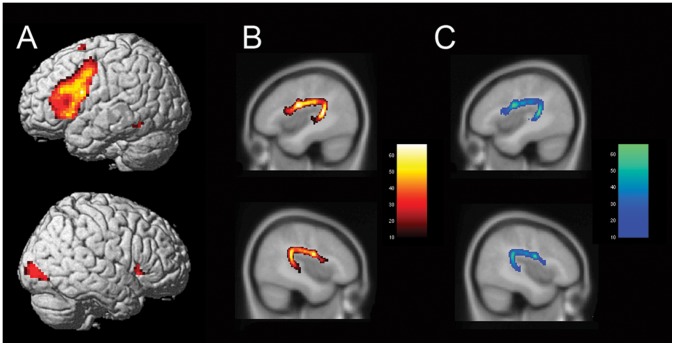
Brain activity and the arcuate fasciculus.Averaged brain activity during word generation task (A) and reconstruction of the arcuate fasciculus on the B) 1% threshold and C) 2% threshold, respectively. Colour bars represent the number of subjects showing arcuate fasciculus fibers in that voxel.